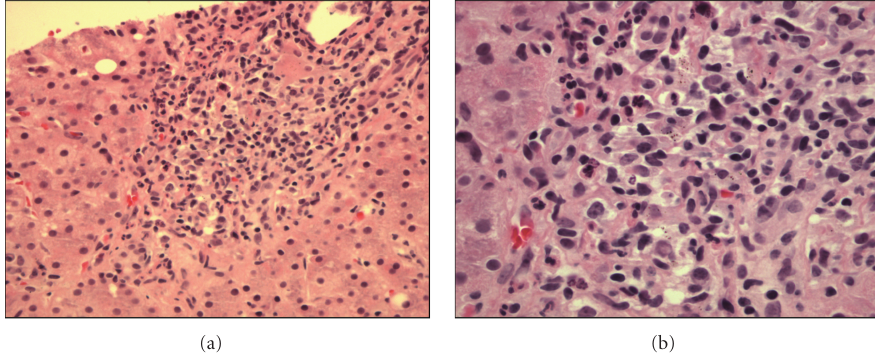
Figure 3: (a) Liver biopsy specimen on H&E stain showing noncaseating granuloma. (b) On greater magnification, the granuloma consists of mixture of inflammatory cells, including epithelioid histiocytes and lymphocytes.